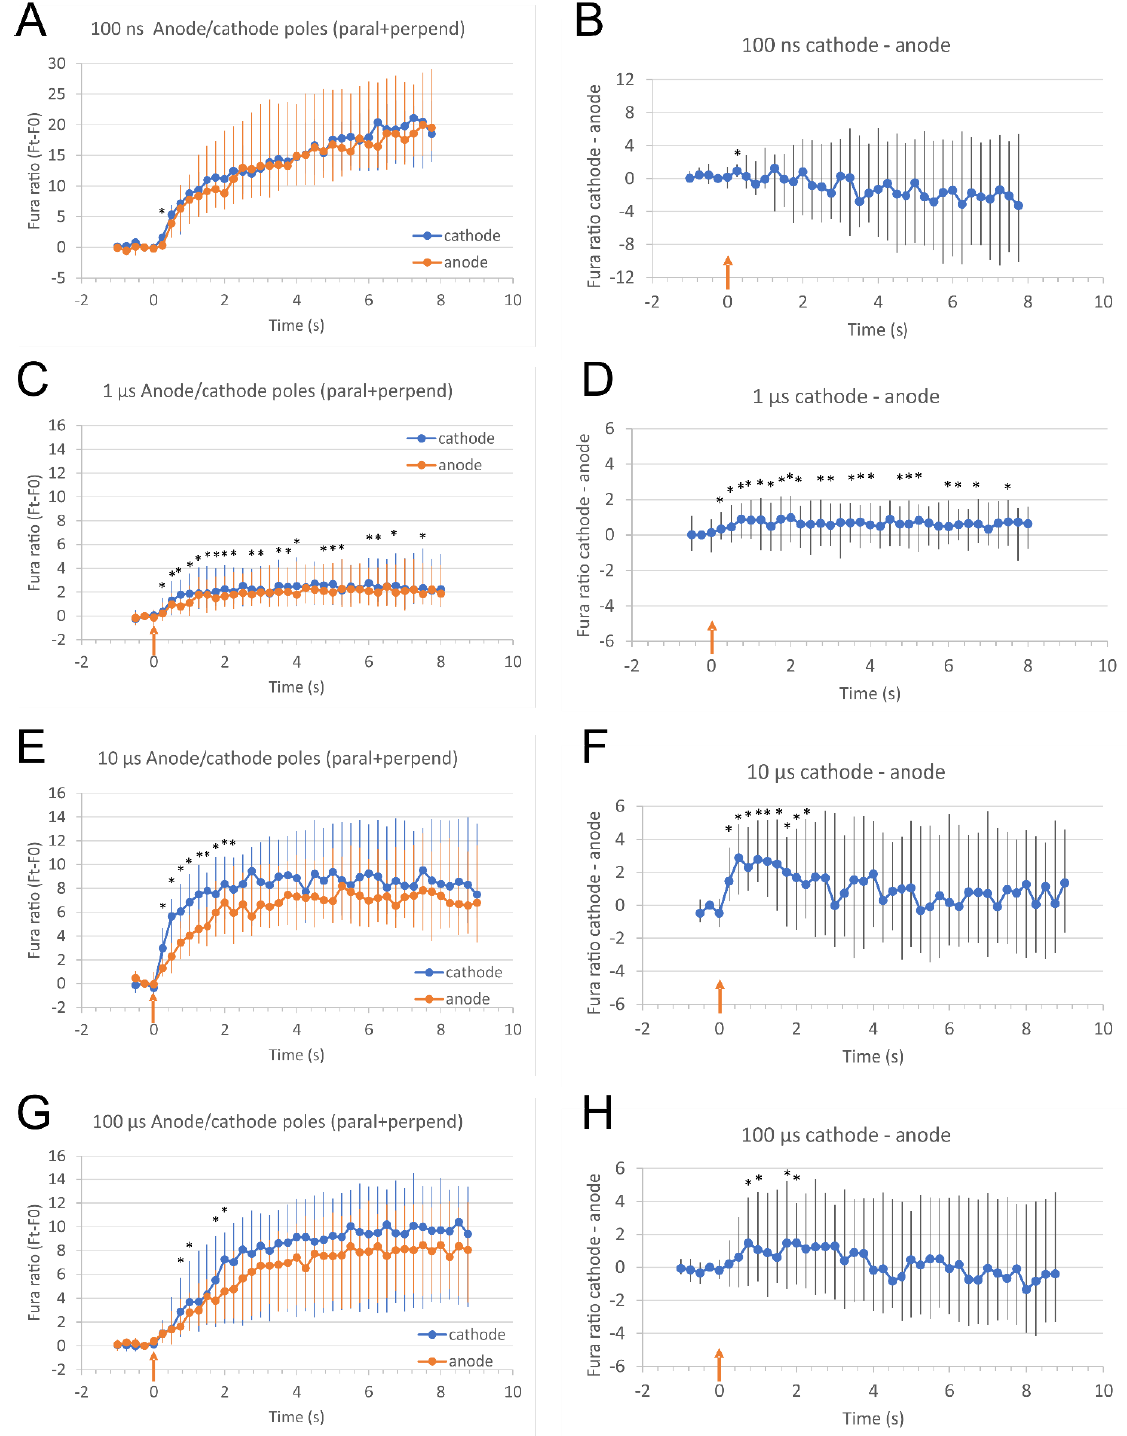
Figure 3. Relative calcium ion (Ca 2+ ) concentration at the poles facing anode (+) and cathode ( − ) in cells (both parallel and perpendicular cells together) ( A , C , E , G ) and fura ratio difference between cathode and anode ( B , D , F , H ) after electroporation with a single 100 ns, 40 kV/cm ( A , B ), 1 µ s, 2500 V/cm ( C , D ), 10 µ s, 1000 V/cm ( E , F ), and 100 µ s, 400 V/cm pulse ( G , H ) as expressed in Fura-2 ratio 340/380 over time. Relative Ca 2+ concentration in cells was monitored with a fluorescent calcium indicator Fura-2, image acquisition was done every 250 ms. Results are presented as median from cells (only parallel